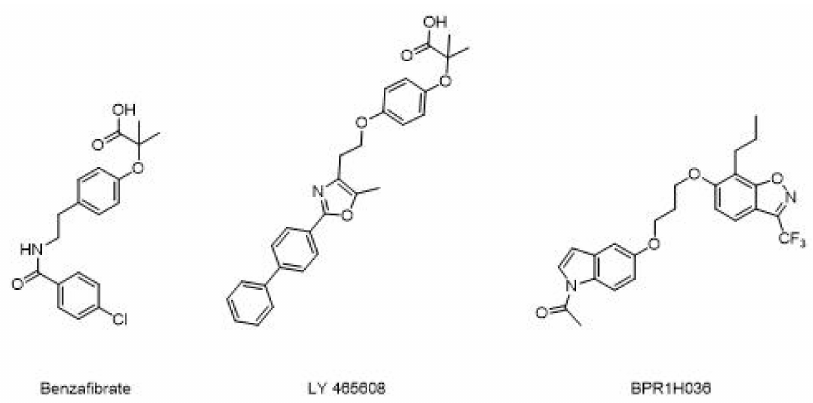
Figure 13. Di ff erent example of PPARs pan